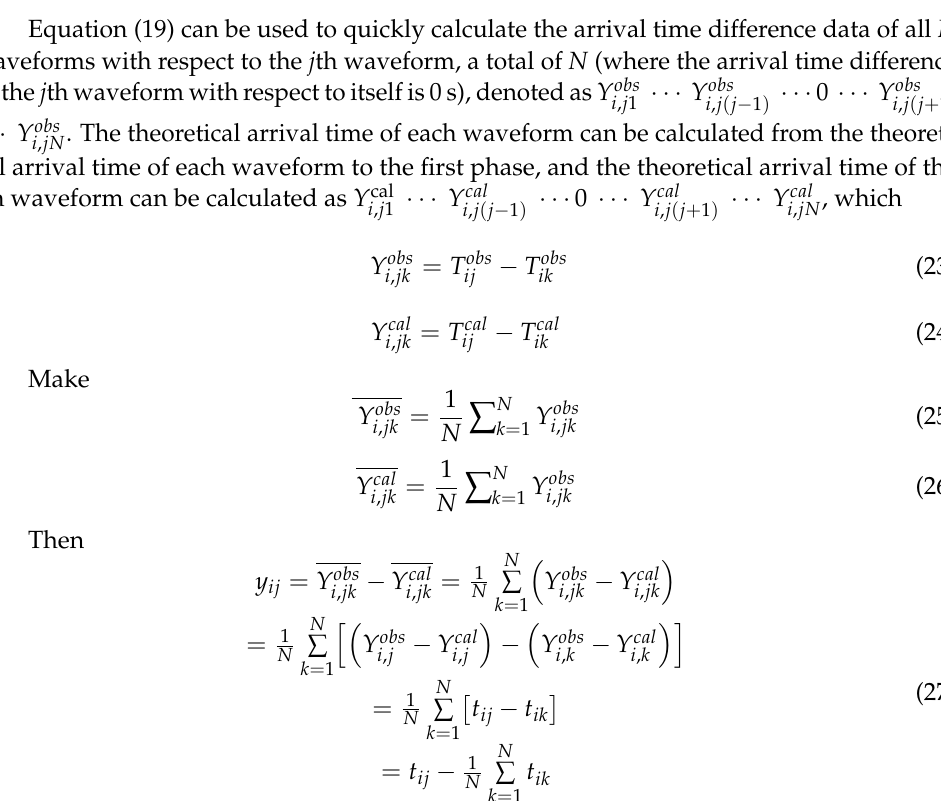
Figure 3. The cross-correlation functions of two time series.